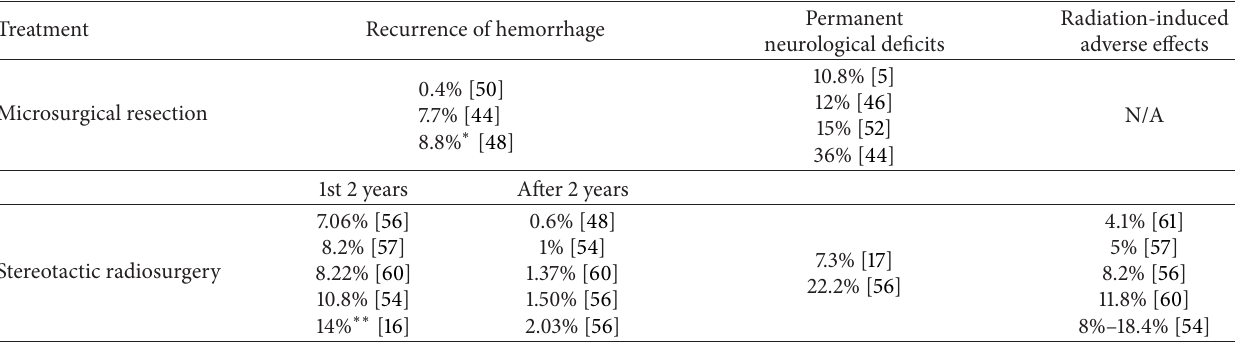
Table 1: Efficacy of treatments for brainstem cavernous malformations